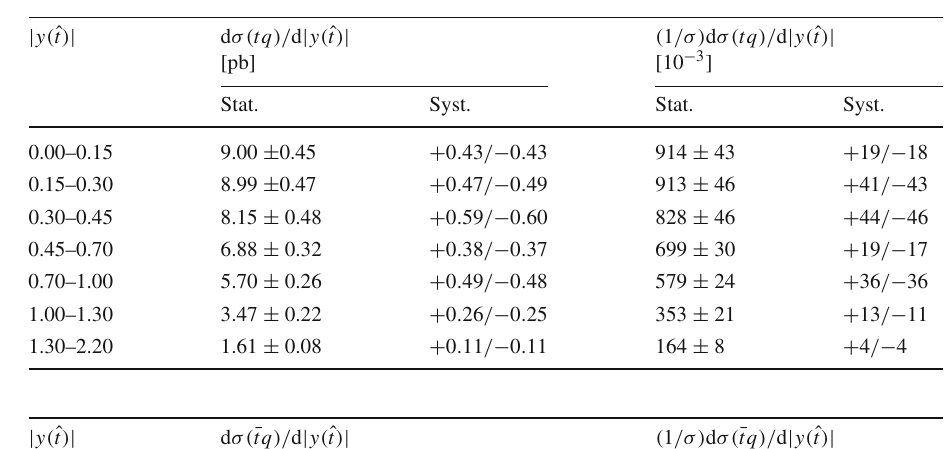
normalised unfolded differential ¯ tq production cross-section as a function of | y ( ˆ t ) | at particle level